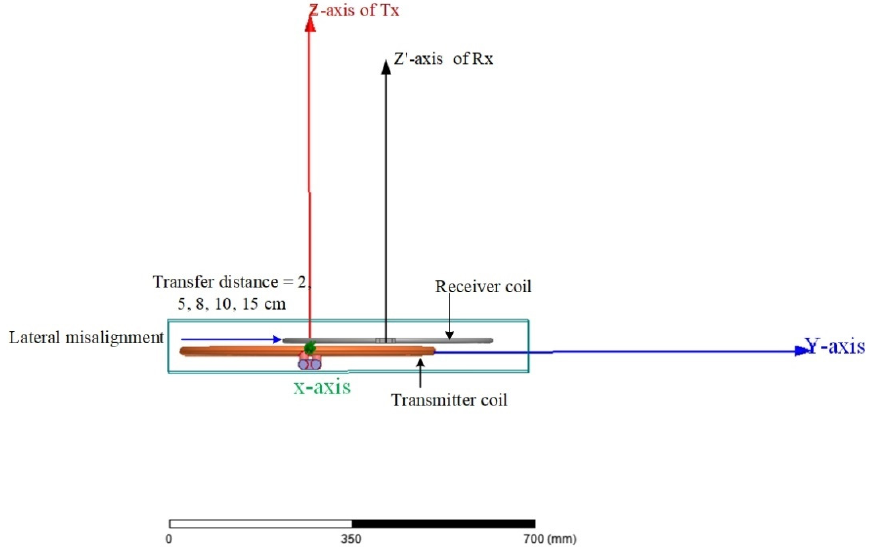
Figure 4. Lateral misalignment distance with the y -axis of lateral misalignment (drone landing) at 2, 5, 8, 10, and 15 cm.